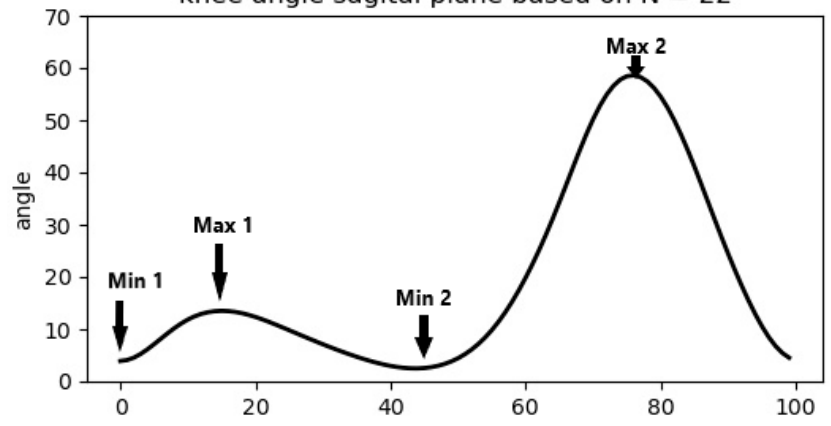
Figure 4. Mean sagittal plane knee-angle curve y-axis = angle in degree (°) in a gait cycle normed to 100% (x-axis) with the four main events as defined and based on the Vicon data of this study (N = 22).